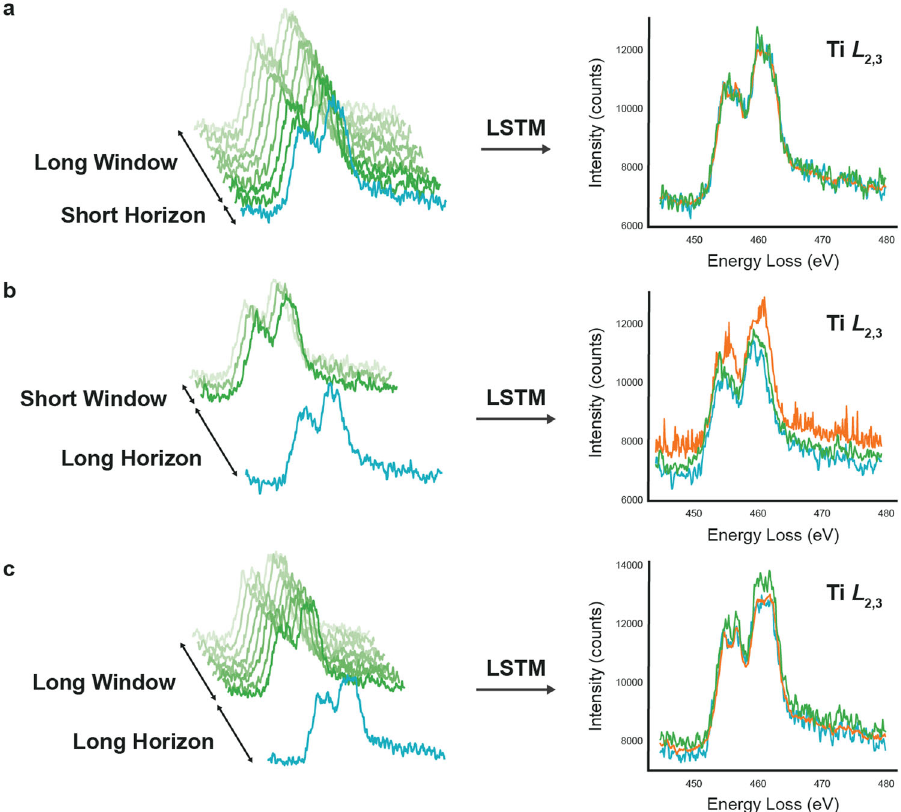
Fig. 3 Input window and output horizon forecast scenarios. a “ Long window, short horizon ” scenario with an eight timestep window and one timestep horizon, demonstrating deceptively good results due to autocorrelation. b “ Short window, long horizon ” scenario with a 3 timestep window and 8 timestep horizon, demonstrating poor results. c “ Long window, long horizon ” scenario, with an 8 timestep window and 8 timestep horizon, indicating good prediction with minimal autocorrelation. The green lines indicate spectra from the input window, the blue lines indicate true future spectra to predict, and the orange line indicates spectra predicted by the LSTM. Note that the plots on the right show only the last spectrum from the input window (in The length of the input window was optimized along with other model hyperparameters in the range of 3 – 15 timesteps, as shown in Supplementary Table 1. Naturally, a suf fi ciently long sequence of spectra must be used to establish the progression of the STO phase transformation, which can then be used to predict future timesteps. We observe poor results when a short input window is used, as shown in the “ short window, long horizon ” scenario in Fig. 3b with a 3 timestep window and 8 timestep horizon.